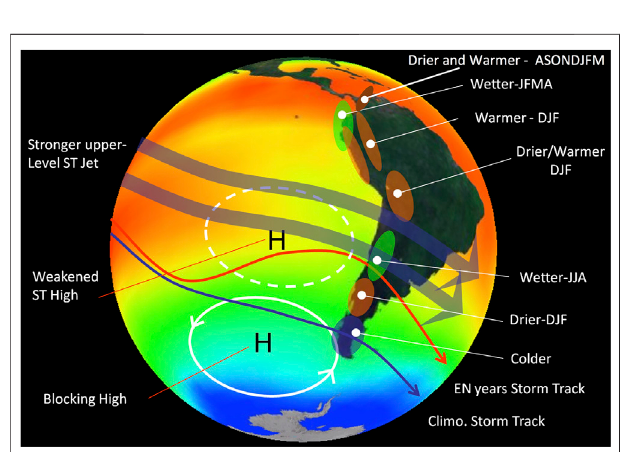
FIGURE 9 | Schematics of the El Niño impacts in precipitation over the Andes. Climate alterations during La Niña events are roughly opposite. “ DJF ” corresponds to the December-January season, “ JJA ” to June-August, “ JFMA ” to January-April, and “ ASONDJFM ” to August-March. “ EN ” denotes El Niño while “ ST ” denotes